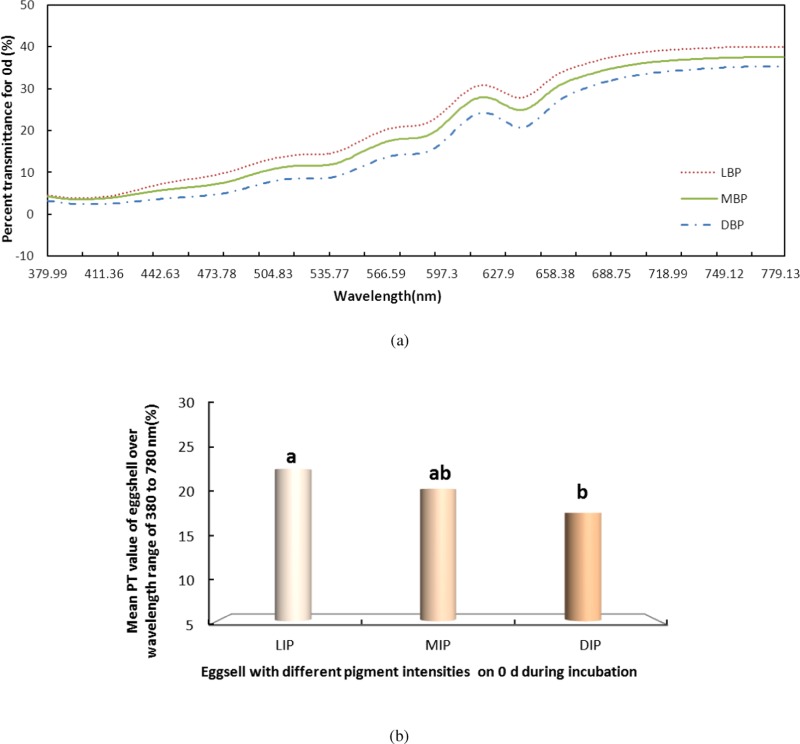
The PT of light over the wavelength range of 380 to 780 nm for the light, middle and dark levels of pink pigment in eggshells on day 0 during the incubation.LIP (L), light intensity pigment; MIP(M), medium intensity pigment and DIP(D), dark. (A) shows the PT of light over the wavelength range of 380 to 780 nm for the light, middle and dark levels of pink pigment in eggshells on day 0 during the incubation. (B) shows the mean PT value of eggshell over the wavelength range of 380 to 780 nm.